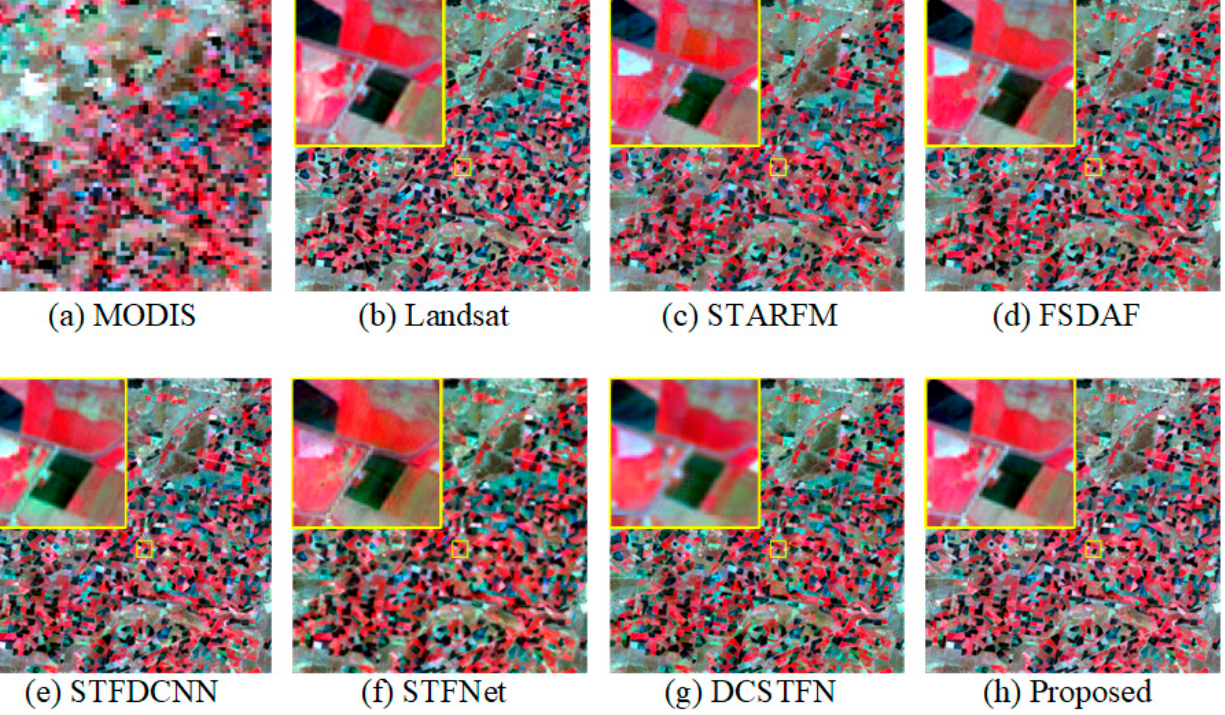
Figure 5. Prediction results of Landsat satellite images (8 November 2001) in the CIA dataset. ( a ) is the corresponding MODIS image, ( b ) is the real image, ( c – g ) are the prediction results of STARFM, FSDAF, STFDCNN, StfNet, and DCSTFN models, respectively, and ( h ) is the prediction result of our model.